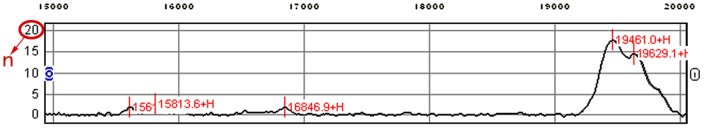
A representative SELDI-TOF MS chromatogram tracing.The tracing scale maximum, n, on the vertical axis of each chromatographic panel was used as the across-chromatogram normalization reference.